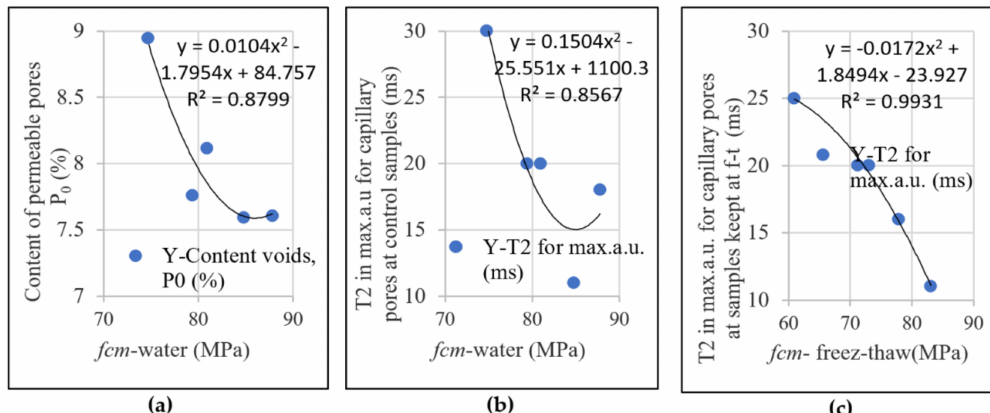
Figure 12. Relationship between compressive strength ( fcm ) and porosity: ( a ) relative to the permeable pore content (P 0 ) in the control samples; ( b ) relative to the relative pore size for the position in which the transverse relaxation time (T 2 ) records the maximum density in the control samples; ( c ) relative to (T 2 ) for the position in which it records the maximum density at the samples kept at freeze–thaw